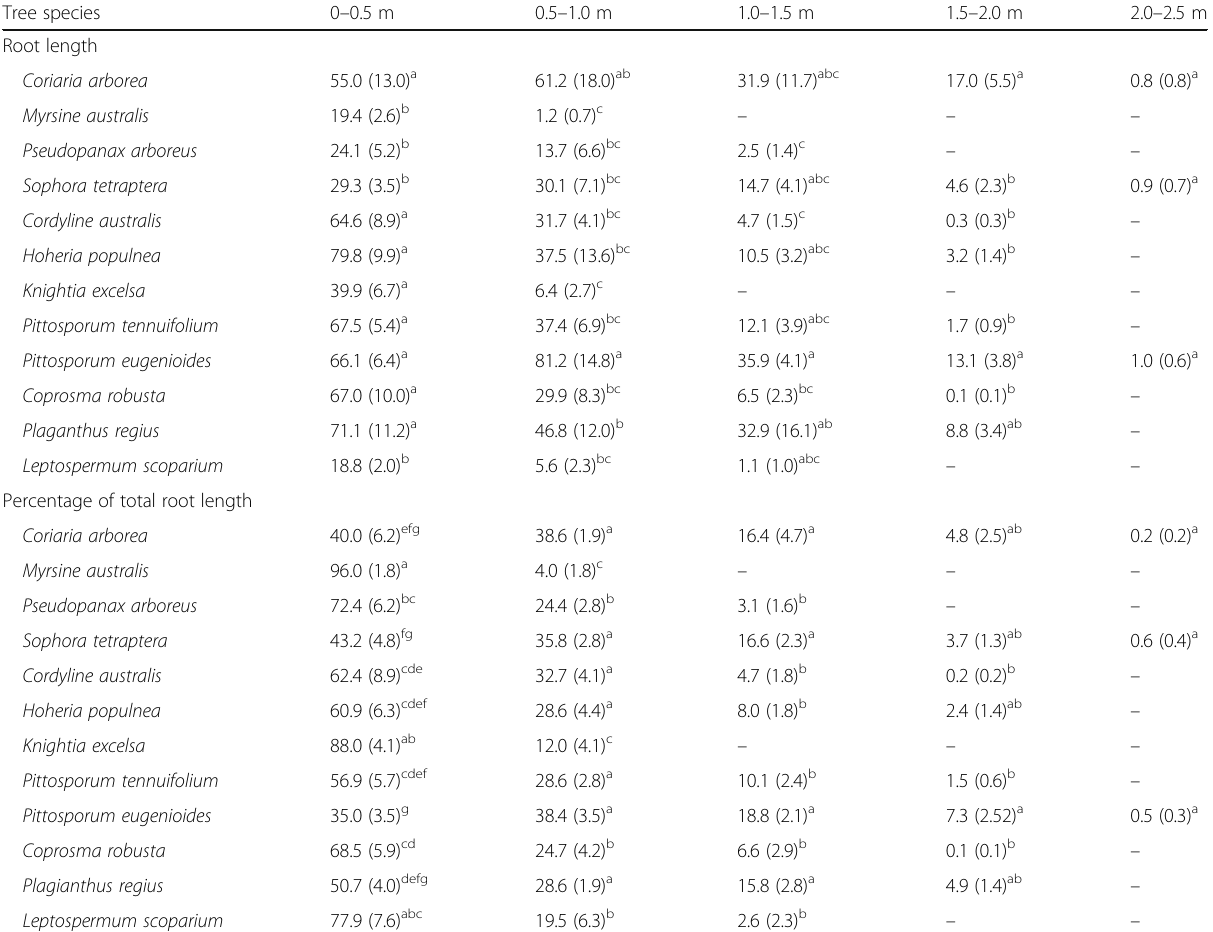
Table 5 Mean total root length (m) and percentage of total root length by 0.5 m radial increment from the root bole by year 5 Tree